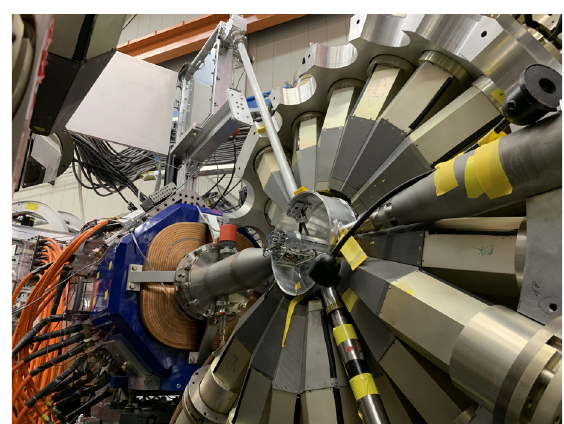
Figure 3. The new β -decay station at Gammsphere showing the Figure 2. Gamma rays in coincidence with the 413-keV γ ray Figure 1. A histogram of a phase-imaging measurement show- tape-transport system and the array of six plastic scintillator de- following the decay of the high-spin, β -decaying state in 160 Eu. ing the positions of 162 m ,g Eu ions on the detector plane. tectors for β -particle triggering.